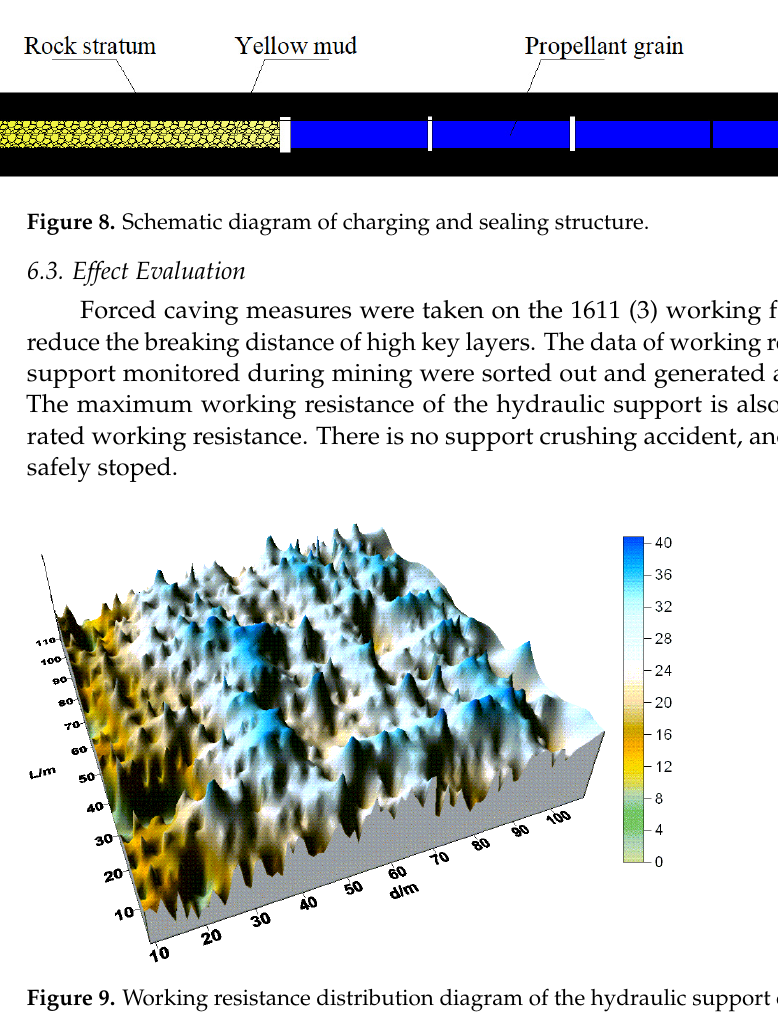
Figure 7. Arrangement plan of the blast.